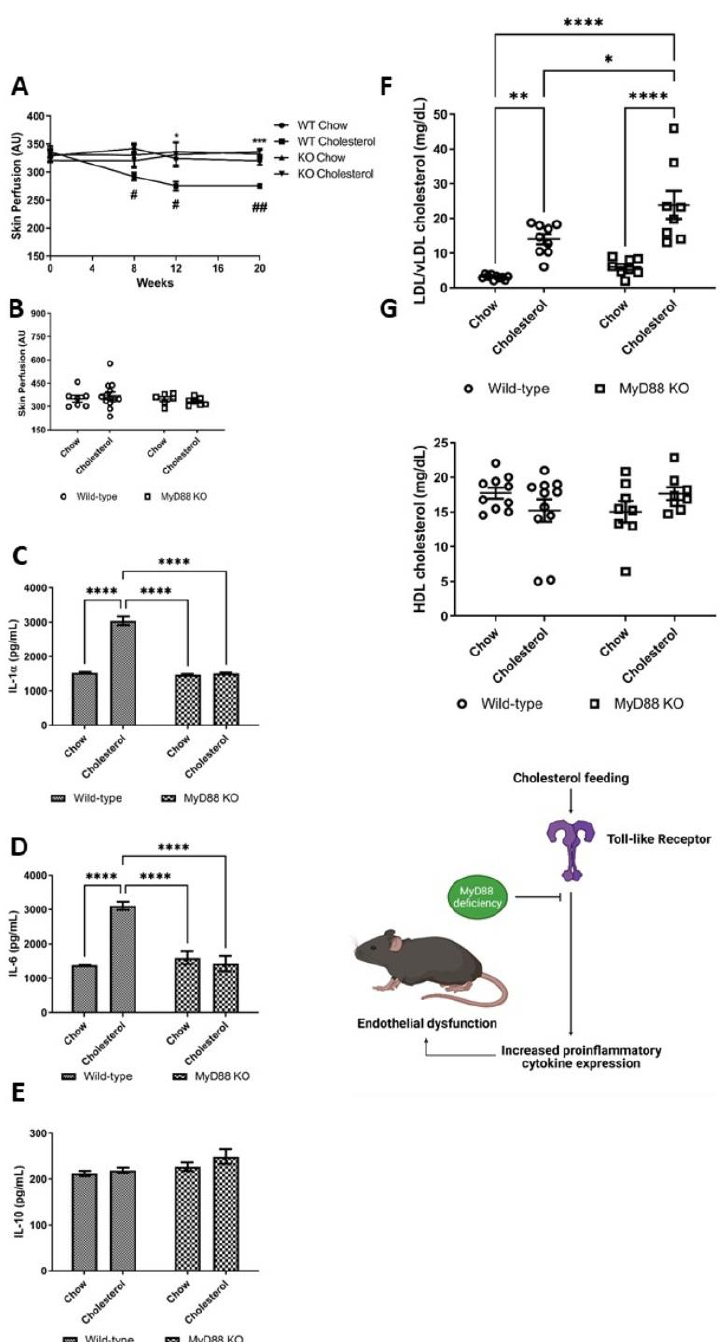
Figure 5. Microvascular responses in MyD88 knockout and wild-type mice. ( A ) Endothelium- dependent microvascular responses in arbitrary units (AU) over 20 weeks and ( B ) terminal endothelium-independent in wild-type (WT)-chow ( n = 9), WT-cholesterol ( n = 15), MyD88 knock-out (KO)-chow ( n = 9) and MyD88 KO-cholesterol ( n = 8) fed animals. Longitudinal changes were anal- ysed by ANOVA for repeated measures followed by post-hoc Bonferroni correction. ( A , B ) * p < 0.05, *** p < 0.001 comparing genotypes, # p < 0.05, ## p < 0.01 comparing diet. Plasma cytokines (pg/mL) ( C ) IL-1 α , ( D ) IL-6 and ( E ) IL-10 WT-chow ( n = 10), WT-cholesterol ( n = 10), MyD88 KO-chow ( n = 10) and MyD88 KO-cholesterol fed ( n = 10) mice. Plasma measurements of ( F ) low density lipoproteins and very low density lipoproteins (LDL/vLDL) and ( G ) high density lipoproteins (HDL) in the plasma of WT-chow ( n = 10), WT-cholesterol ( n = 11), MyD88 KO-chow ( n = 8) and MyD88 KO-cholesterol fed mice ( n = 8) (mg/dL). ( C – E ) two-way ANOVA. Values are group means ± SE. * p < 0.05, ** p < 0.01, **** p <